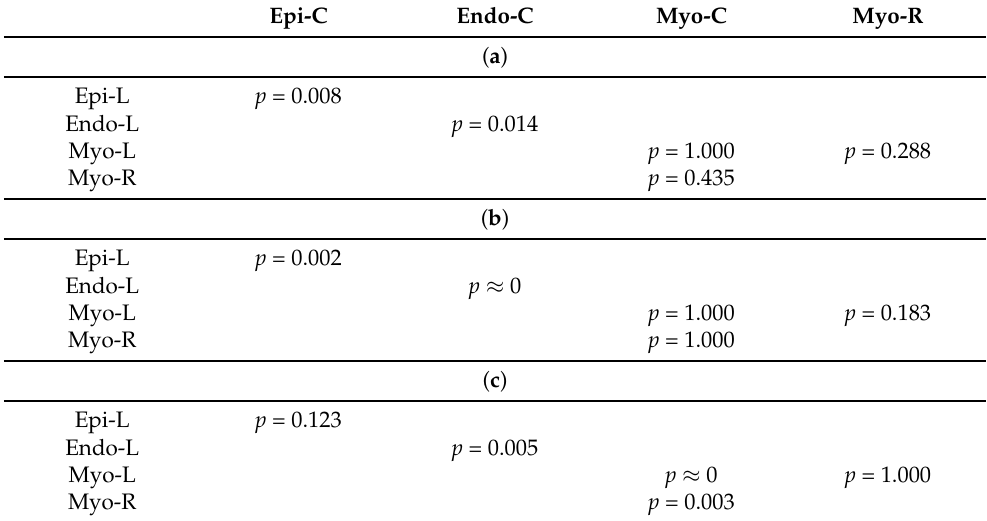
Figure 7. Boxplot for analyzing the wave speed depending on both location and layer. Red line: median, Upper black line: maximum, Lower black line: minimum, Top of the blue box: first quartile (25 %), Bottom of the blue box: third quartile (75 %), Red cross mark: outliers. ( a ) Epicardium, ( b ) Myocardium, and ( c ) Endocardium (L: longitudinal, C: circumferential). Table 2. p -values for the locations. ( a ) Apex, ( b ) Mid, and ( c ) Base. (L: longitudinal, C: circumferential, and R: